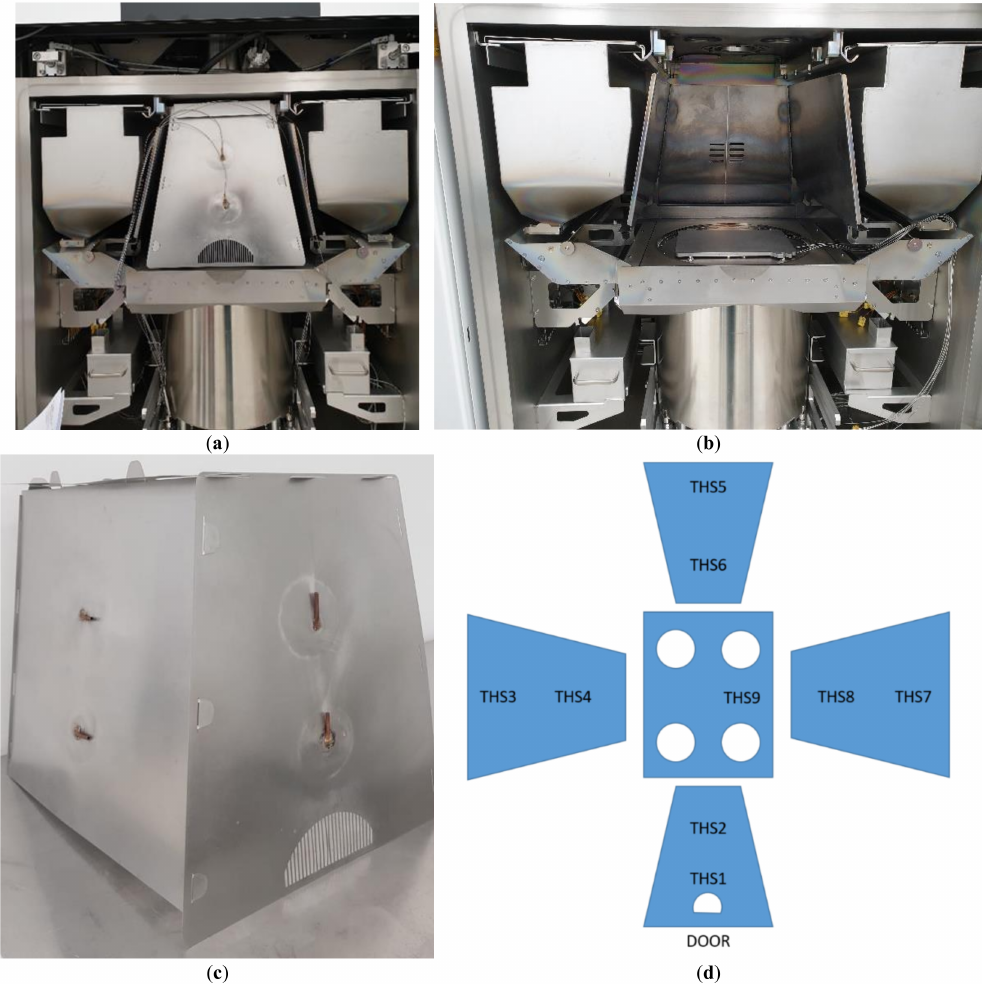
Figure 4. Experimental setup for the Q20+ build chamber: ( a ) front view with the heat shield, ( b ) front view without the heat shield, ( c ) the main heat shield with thermocouple sleeves, ( d ) schematics of thermocouple locations in the heat shield (THS—thermocouple heat